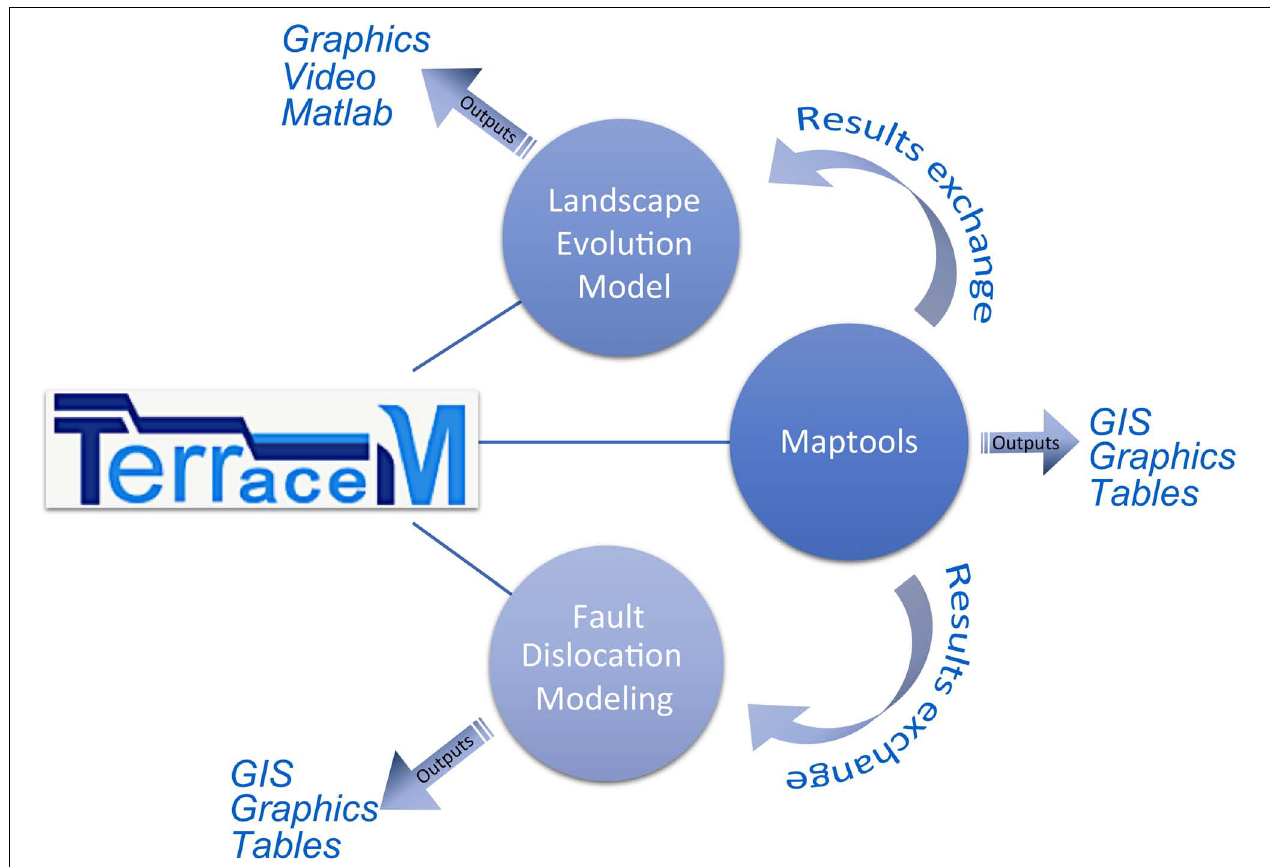
FIGURE 1 | Structure of TerraceM-2 modules, exchange of results between modules, and